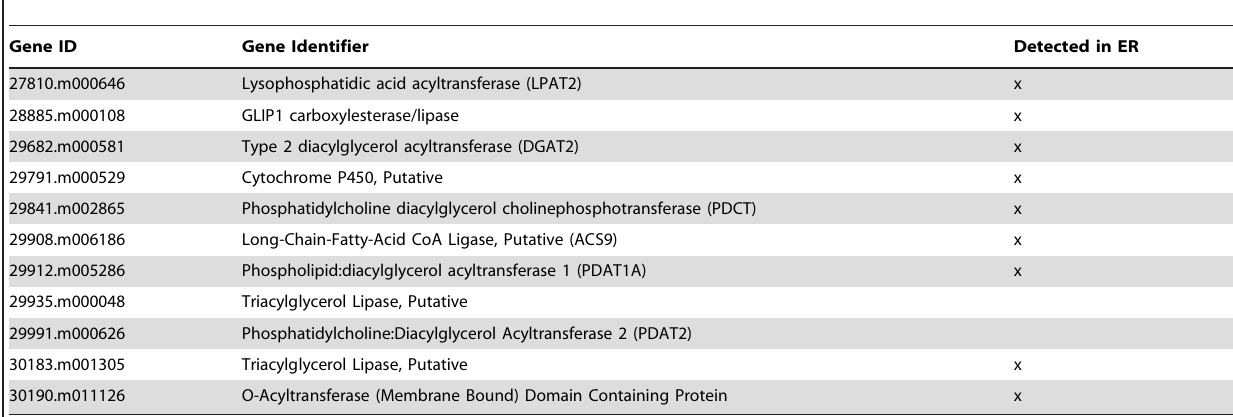
Table 3. Candidate genes that may be important in tri-ricinolein synthesis based on RNA-Seq data.